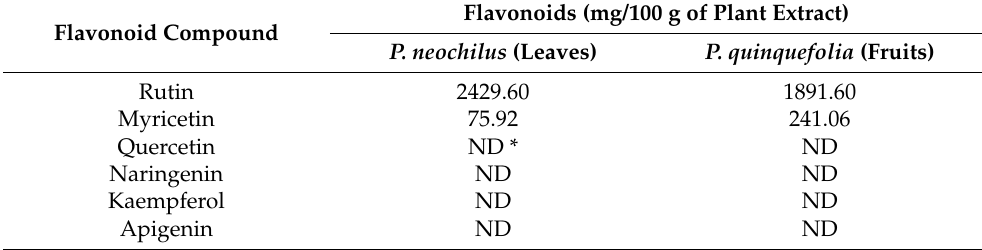
Table 4. Flavonoid compounds identified of the methanol extracts from P. neochilus leaves and P. quinquefolia fruits by